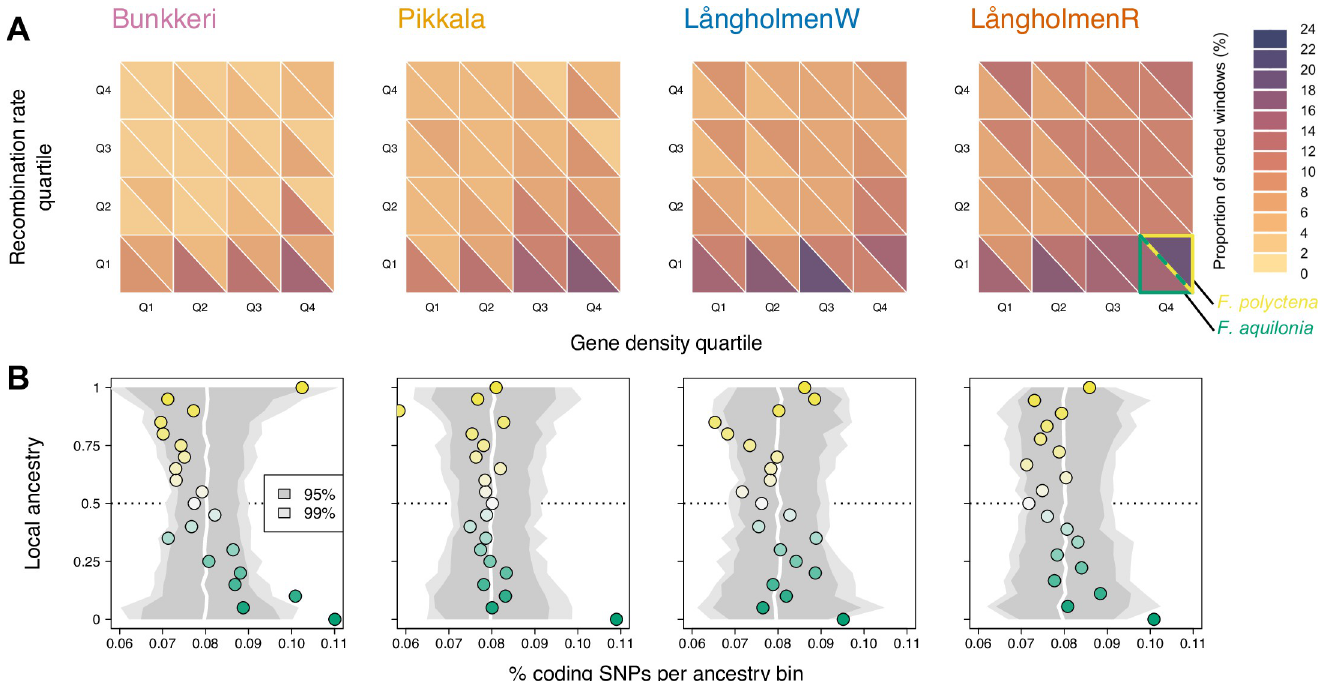
Fig 3. Sorting of ancestral polymorphism in hybrids is driven by recombination rate variation and genetic load. (A) Heatmap showing the fraction of sorted 20 kbp windows and the direction of sorting (ancestry component fixed) as a function of recombination rate and gene density quantiles in each hybrid population. (B) Coding regions are significantly enriched for the F . aquilonia ancestry component in all hybrid populations ( P < 0.002). For each population (panel, same as A) is plotted local ancestry (y-axis, 0: F . aquilonia allele fixed, 1: F . polyctena allele fixed) as a function of the fraction of SNPs within CDS (x-axis). Confidence intervals (in gray) were obtained using 500 genomic permutations (white line: median of the permutation approach). The data underlying this figure can be found in https://doi. org/10.6084/m9.figshare.c.6140793.v3. CDS, coding sequence; SNP, single-nucleotide polymorphism.